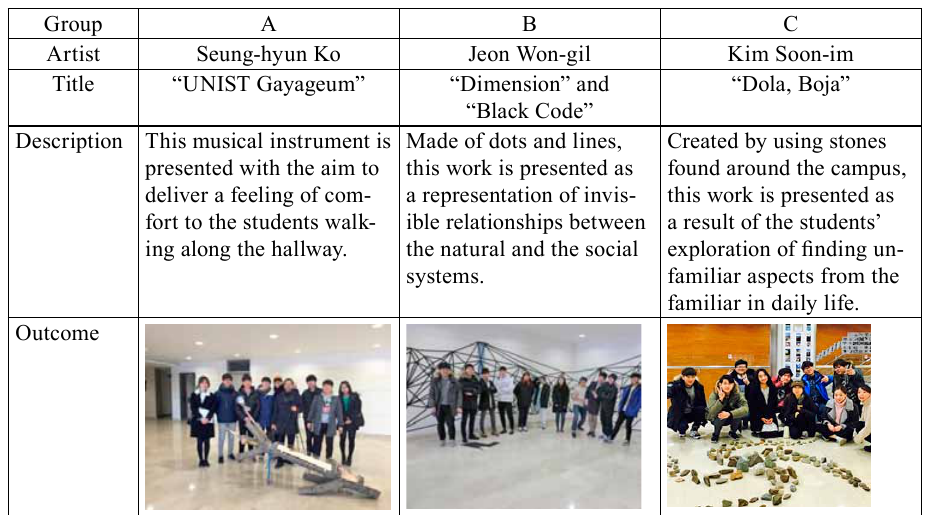
Table 4. Descriptions of three group projects (created by author) group a b C artist “unisT gayageum” “Dimension” and Description This musical instrument is presented with the aim to deliver a feeling of com- fort to the students walk- ing along the hallway.